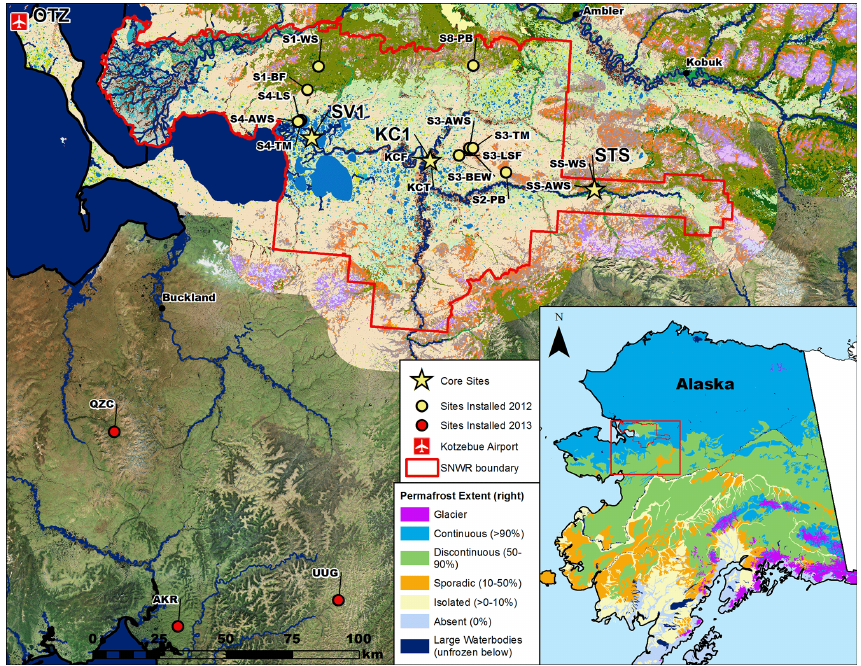
Figure 1. The map of the location of our research sites in the study area, the SNWR, northwestern Alaska. The ecotype map (Jorgenson et al., 2009) is shown in the background where